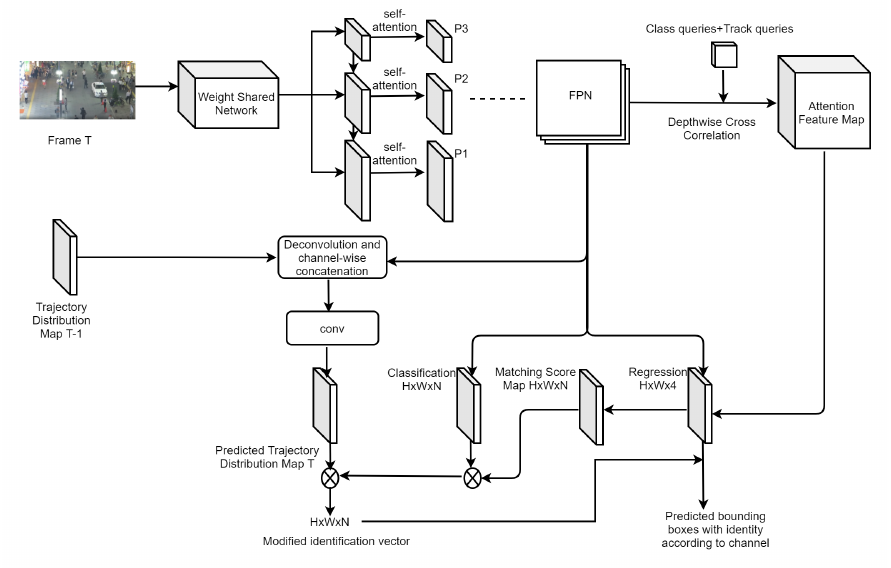
Figure 1. Network architecture of TdmTracker. After the current frame is input to the network, an FPN is obtained first. Given the optimized class queries, track queries in adaptive query embedding set, through query-key attention mechanism, a classification result for the objects corresponding to each query is obtained. On the other hand, trajectory distribution map of previous frame is input to the network for the branch of predicting trajectory distribution map of current frame, which guides position prediction for each tracked object and produces modified identification vector. This modified identification vector in turn guides the post-processing process of the prediction bounding